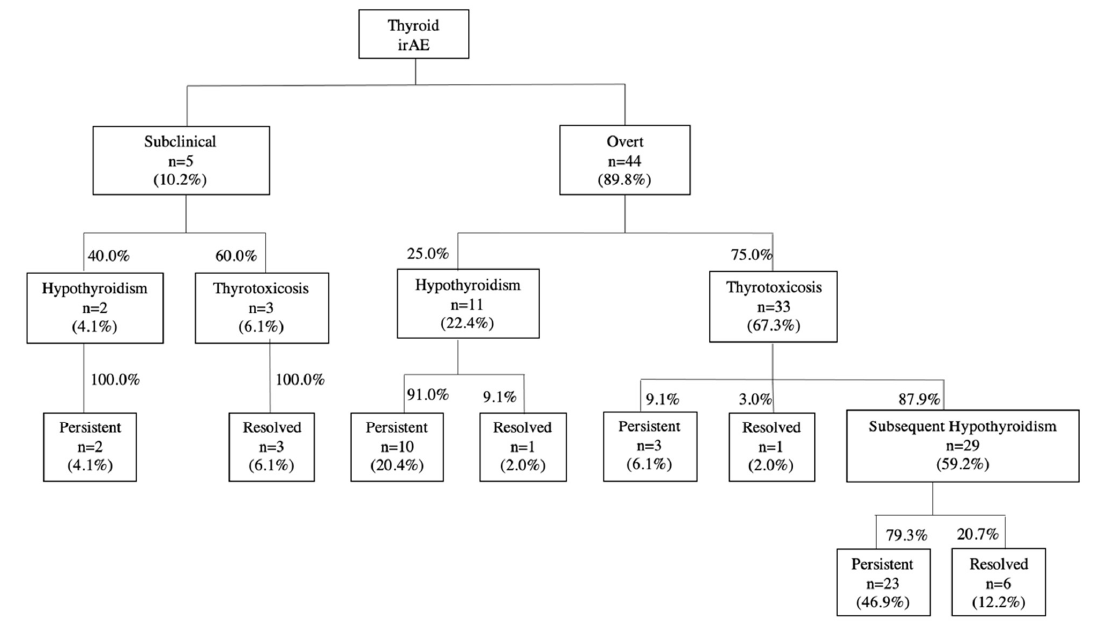
Figure 2. Evolution of thyroid dysfunction over time ( n = 49) .